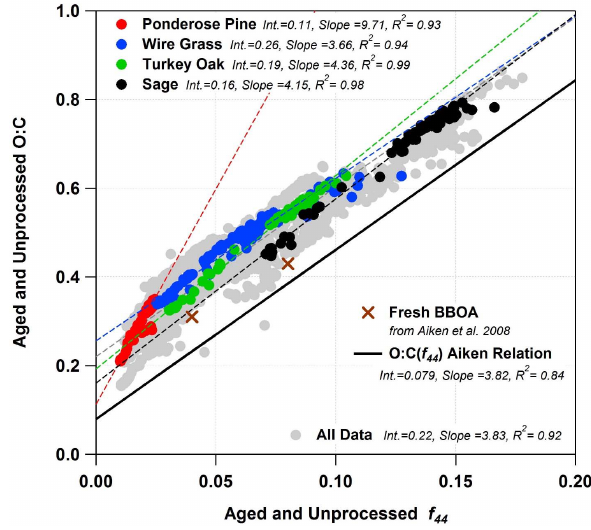
Fig. 13. Aged and unprocessed smoke O/C as a function of f 44 for all burns with four fuels highlighted (ponderosa pine, burn 40; wire grass, burn 42; turkey oak, burn 45; and sage, burn 49). Each highlighted burn, as well as all data, is fitted with a linear ODR fit. The fit of Aiken et al. (2008) of O/C vs. f 44 for ambient Mexico City measurements is plotted with BBOA-only data from that study highlighted for